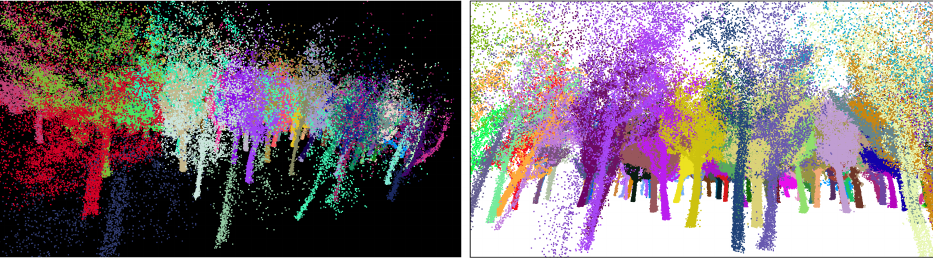
Figure 14. Orthographic view of the whole point cloud segmented (geometrical scale in meters).